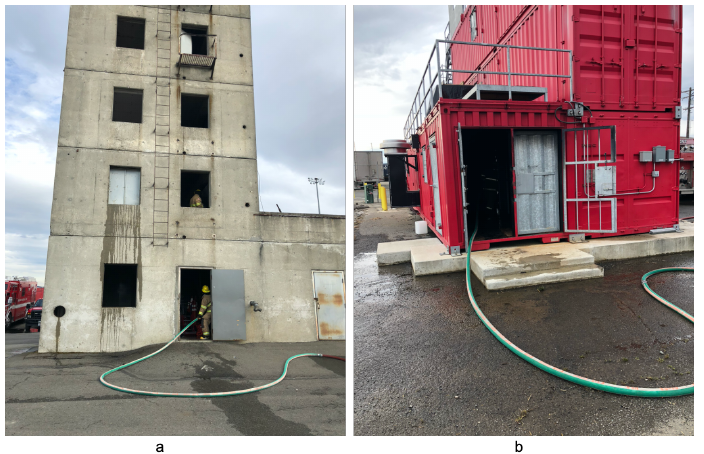
Figure 4. ( a ) Photo of concrete building used for live-fire experiments with Fire Department teams. ( b ) The second building was composed of multiple stacked corrugated metal shipping